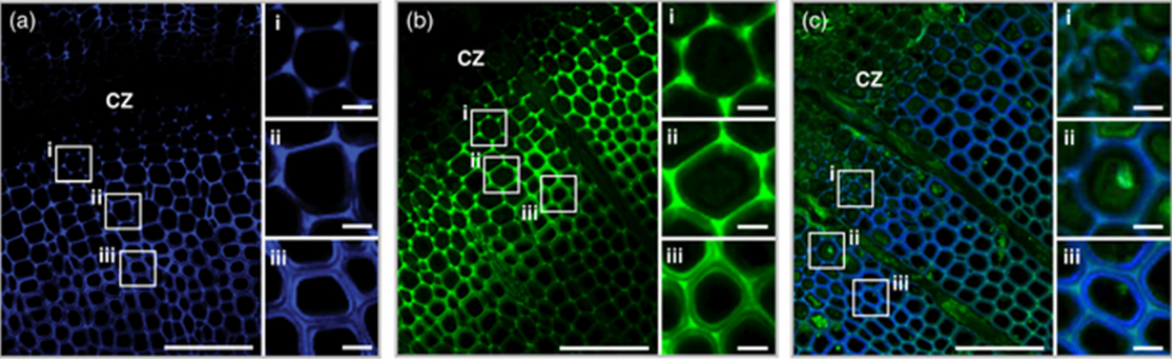
Figure 5. Transverse sections of Pinus radiata stem labelled with two fluorescent probes (DMAC-tagged monolignol probe, DG; NBD-tagged monolignol probe, NG) showing developing xylem tissues around the cambial zone (CZ). ( a ) Fluorescence of DG (purple); ( b ) fluorescence of NG (green); ( c ) fluorescence of DG (purple) and autofluorescence (green). Scale bar = 100 µm in wide-field and 10 µm in magnified images. Figure from